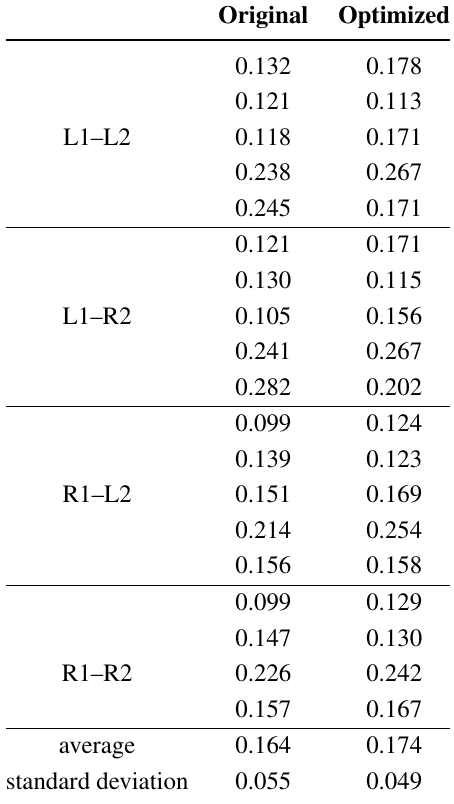
Table 3. Differences between the position of the control points on site and the position in the point cloud, both for the original Lynx Mobile Mapper data ( Left ) and the optimized point cloud ( Right